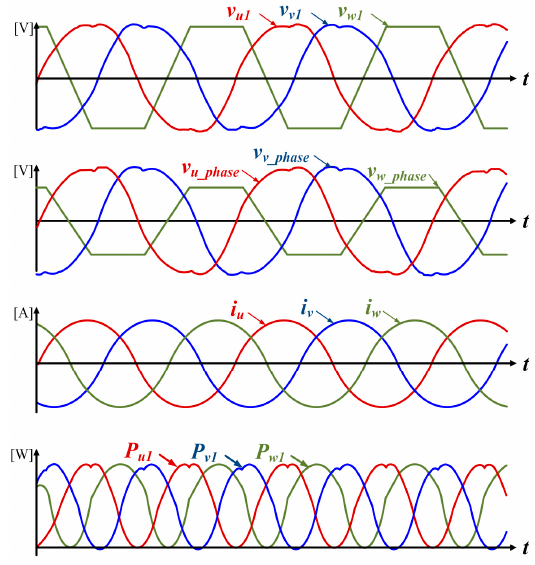
Figure 11. The main waveforms in the proposed neutral-point voltage-shifting control.